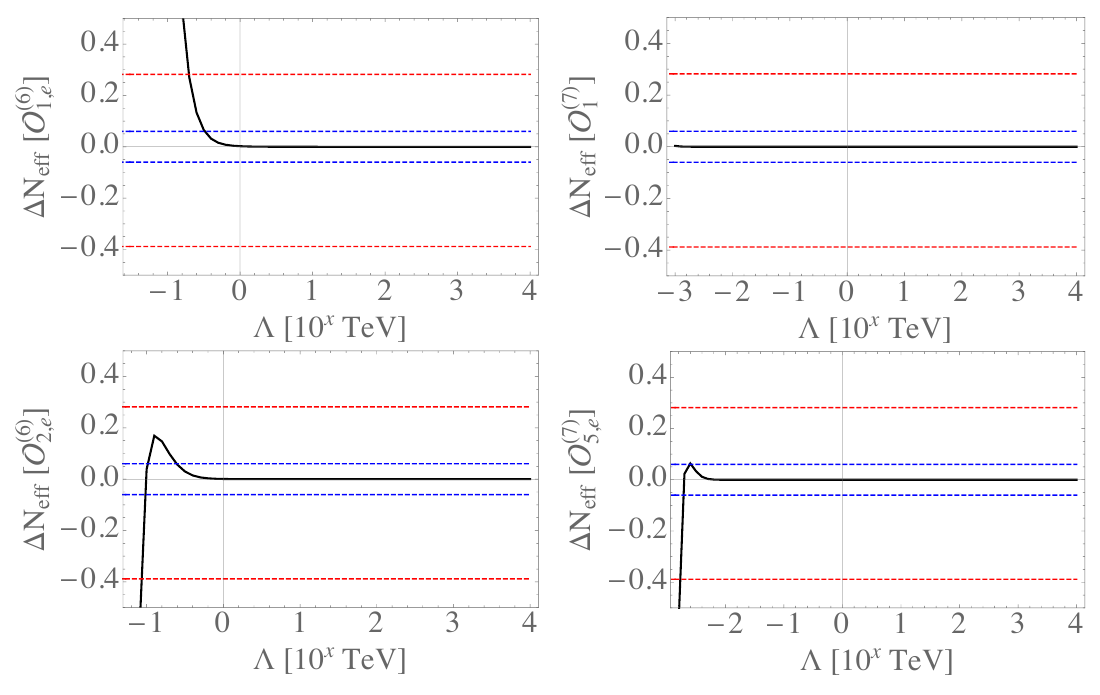
only. Figure 2 . Corrections to N eff from varying Λ . Upper left: ∆ N eff with the inclusion of O (6) 1 ,e Very similar plots are obtained for other operators except for O (6) , O (7) , thus we only (2 ,e ) , 3 , 4 , 5 1 , 2 , (5 ,e ) show O (6) for illustration. Upper right: ∆ N from O (7) only. Very similar plot is obtained for O (7) . eff 1 ,e 1 2 Lower left: ∆ N from O (6) only. Lower right: ∆ N from O (7) only. In all these subfigures, the eff eff 2 ,e 5 ,e black curve stands for corrections to N from the related NSI operator, the horizontal red dashed eff line is the constraint on ∆ N from Planck, and the horizontal red dashed line is that from eff